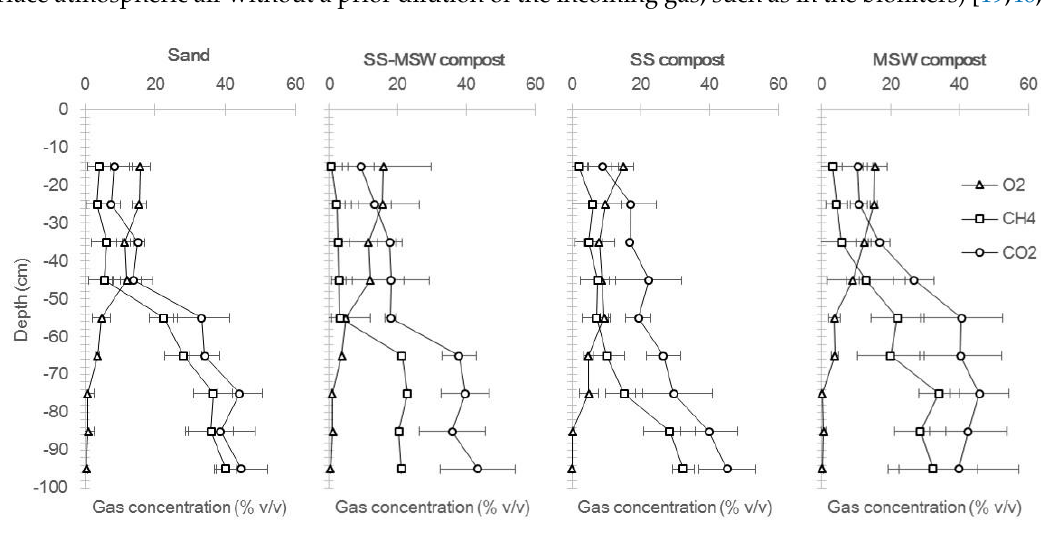
Figure 3. Average gas composition profiles.